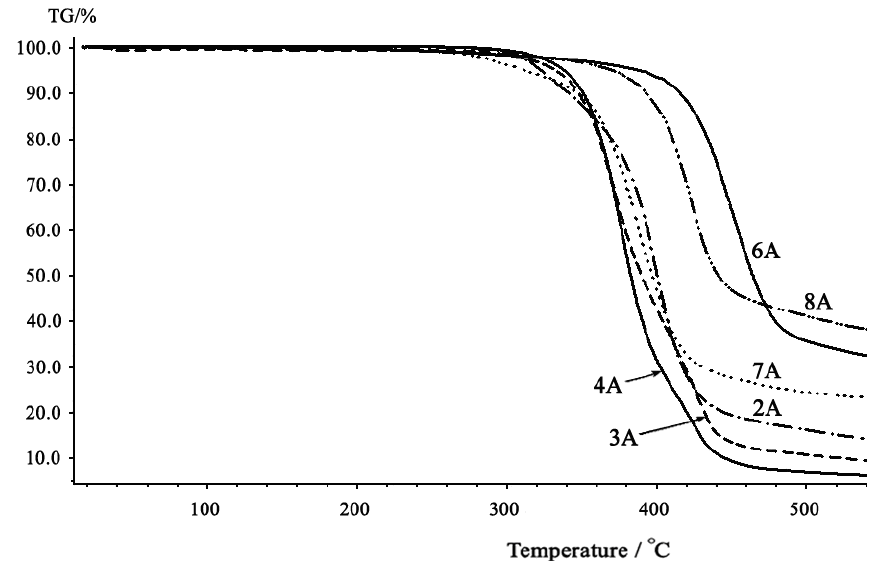
Figure 7 . TGA thermograms of polycarbonates (Series A). TG % is the mass percentage of the polymer sample remaining after heating the polymer to a high temperature.